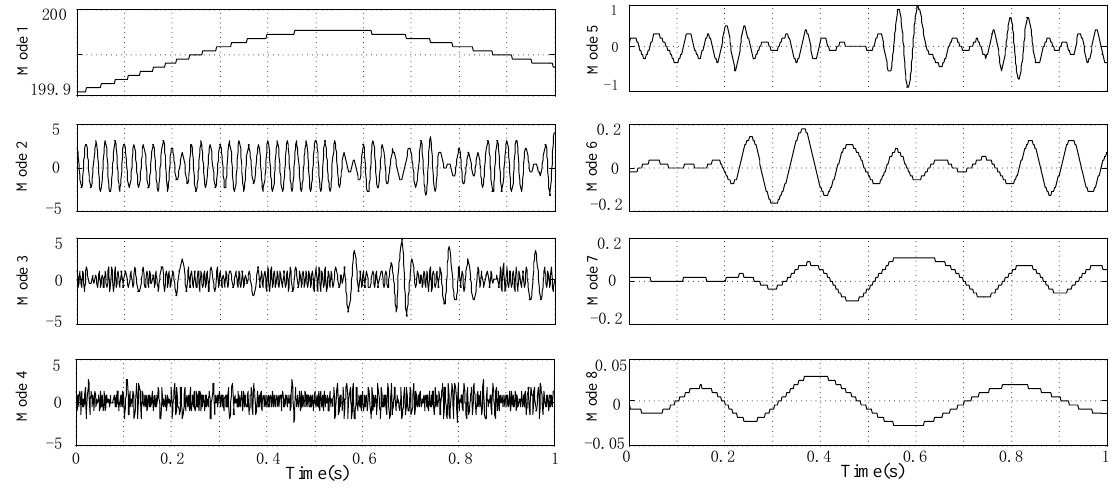
Figure 13. The decomposed modes of VMD-HT algorithm.